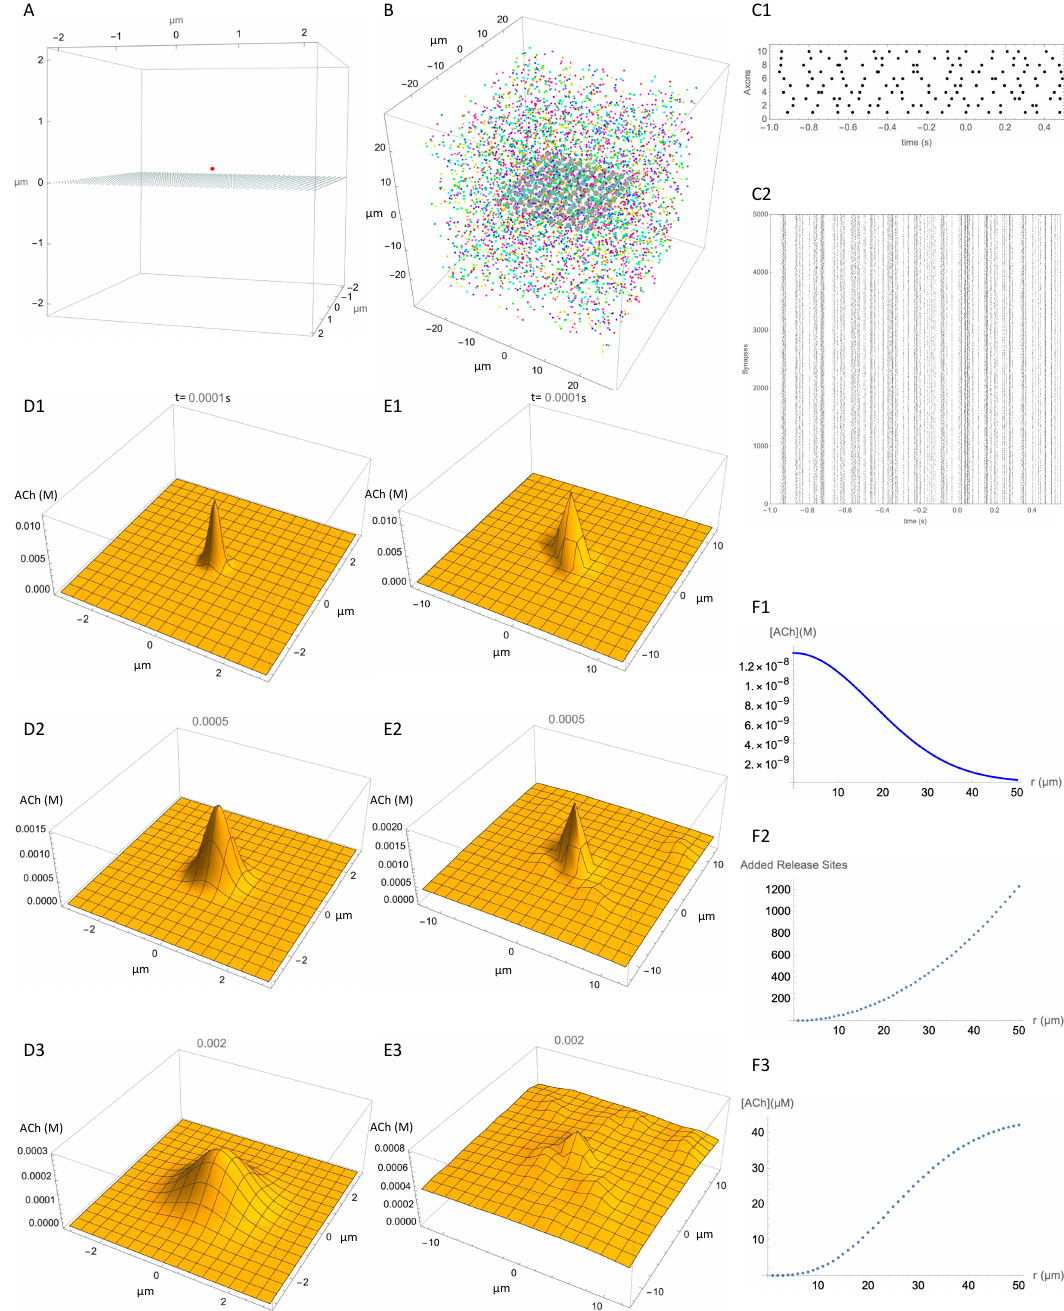
Figure 3. Spatial resolution of ACh signal. ( A ) Reference release site (red dot) positioned 0.2 μ m above an observation plane at z = 0, to show spatial spread from a single release site. ( B ) Multiple release sites (typically 5000) distributed within a 50 × 50 × 50 μ m cube, with an observation plane at z = 0. ( C1 ) Action potential firing times (black dots) for 10 axons. ( C2 ) Unsorted release event times (small dots) for each of the 5000 release sites (“Synapses” for convenience of description) over 1.5 s of simulation. ( D ) Still images of the successive temporospatial changes in concentration caused by a release event at the reference release site at time t = 0 s and ( D1 ) 0.0001 s, ( D2 ) 0.0005 s, ( D3 ), 0.002 s. Note different scales for concentration at each time point. ( E ) Same as D but with release events at all 5000 release sites in the block in addition to the reference activity. Timing of release events is as shown in ( C ). ( E1 ), 0.0001 s, ( E2 ) 0.0005 s, ( E3 ), 0.002 s. ( F1 – F3 ) “back of envelope” type calculation of contribution of all release sites to concentration at reference site. See text for explanation.